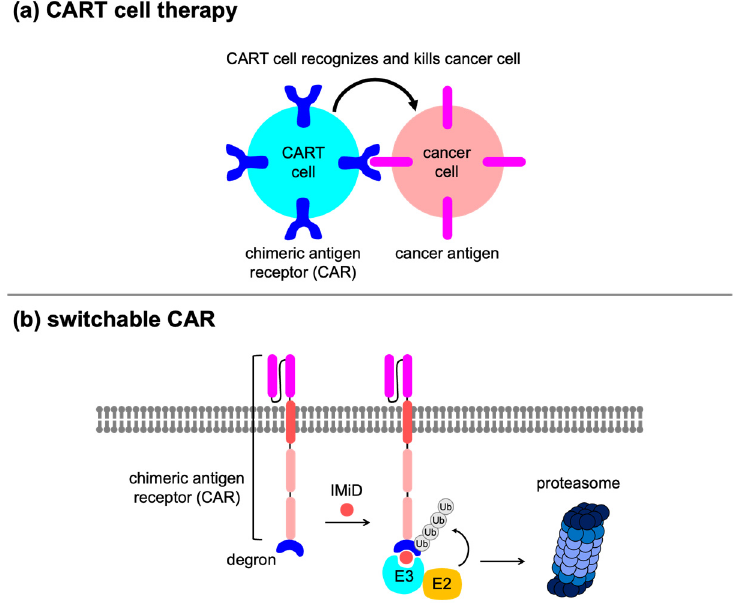
Figure 7. Applications of technologies for post-translational control of protein expression. Schematic diagrams of ( a ) CART cell therapy and ( b ) switchable CAR for CART therapy.